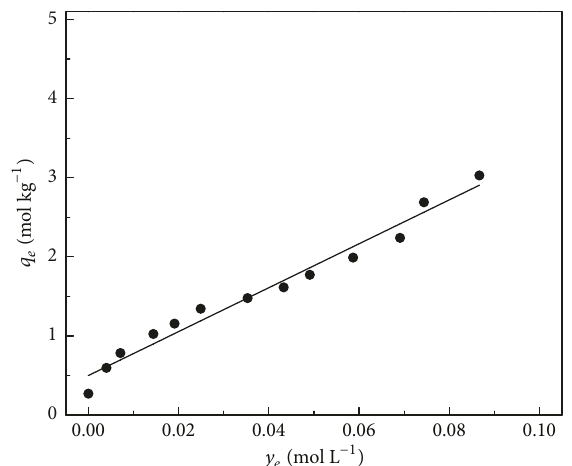
Figure 5: Adsorption of oleic acid from methanol at room temper- ature (30 ∘ C) and overactivated carbon (Calgon Carbon Filtrasorb 200). Correlation coefficient for Henry’s constant (slope of the line), 𝑟 2 = 0.97 .